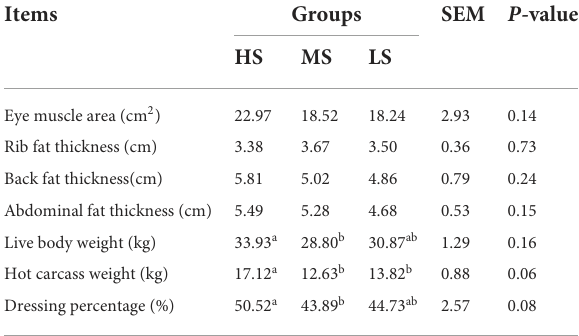
TABLE 2 Effect of different energy level diets on the carcass quality of Tibetan sheep.